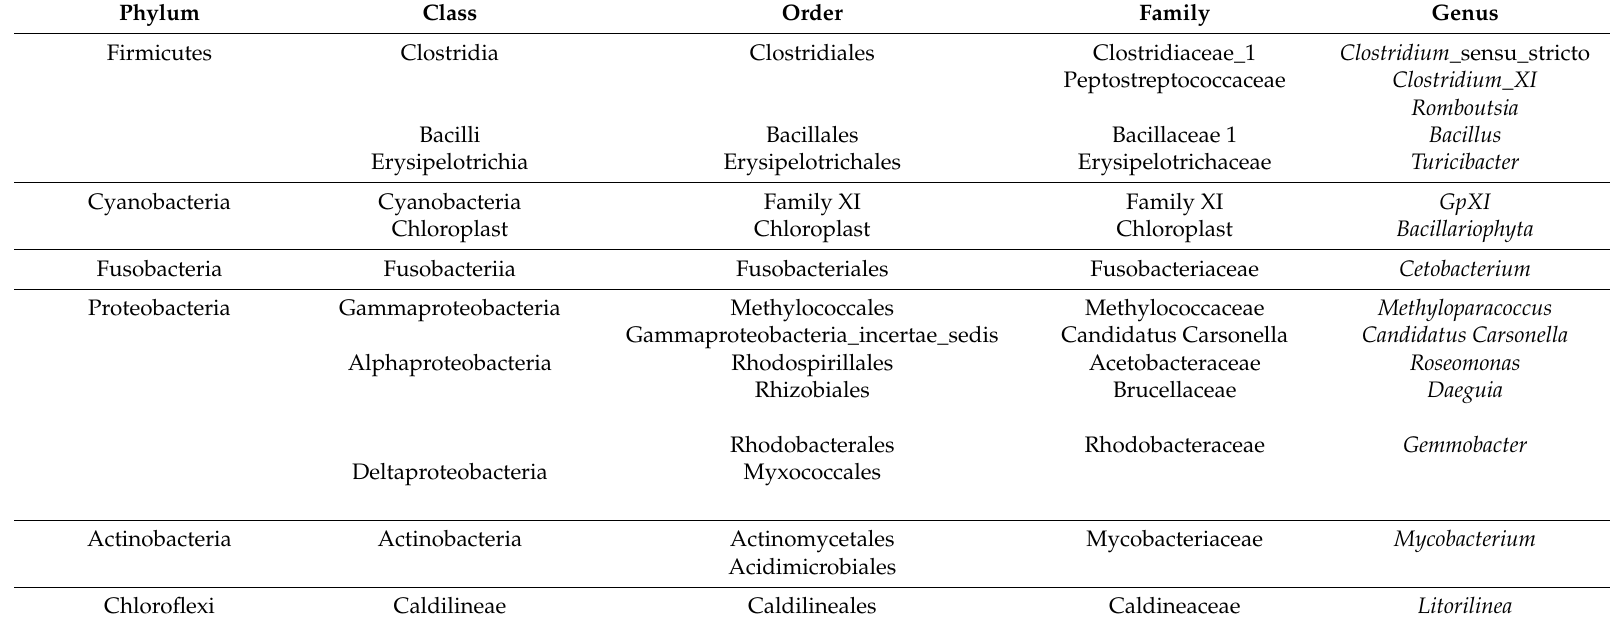
Table 1. List of the core